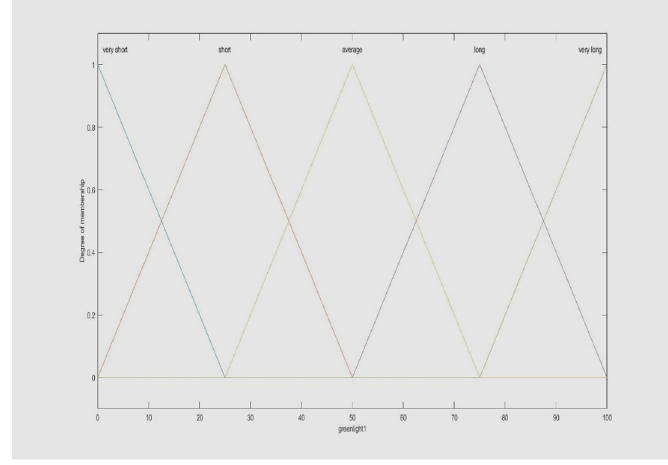
Figure 4. Output from fuzzy controller for junction 1 with five linguistic values. The control surface plot depicts two independent input variables (numbercars1 and numbercars2) and an output variable (greenlight1–duration of green light for Section 1)— Figure 5. The color of the surface is of no significant importance here as it corresponds to the value of the z axis—the lower the value, the colder the color, and the higher the value, the hotter the color. Mainly, there are three colors: blue, green, and yellow for low, middle, and high values of the duration of the green light for Section 1, respectively. The control surface plot is uneven. It has peaks and valleys caused by the heuristic rules that are de- fined.